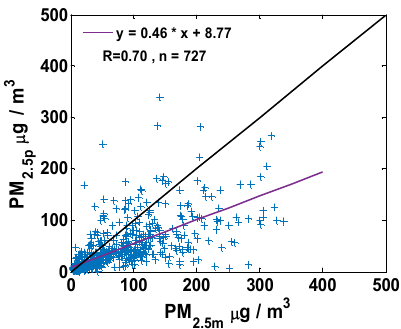
Figure 10. Validation results of predicted PM 2.5 and in situ measured PM 2.5.